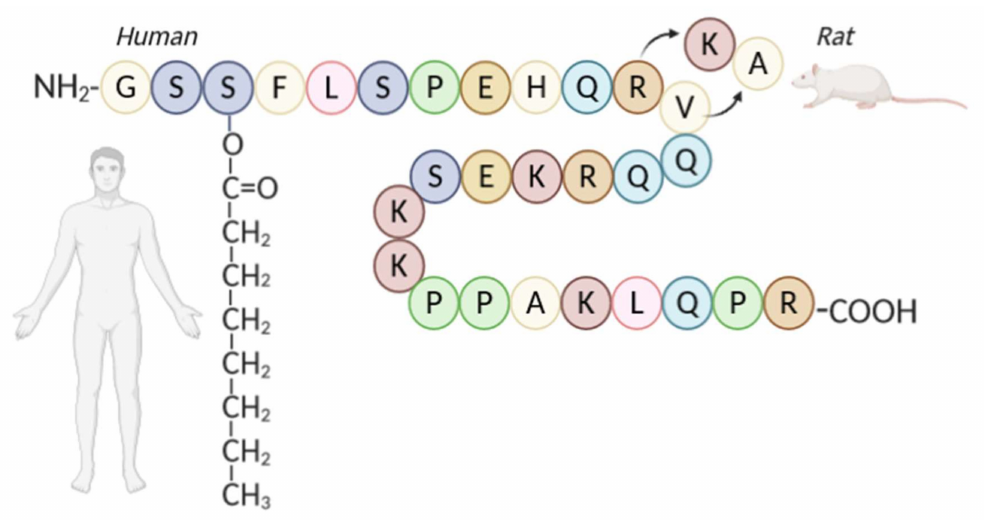
Figure 3. Structure of ghrelin in a human and